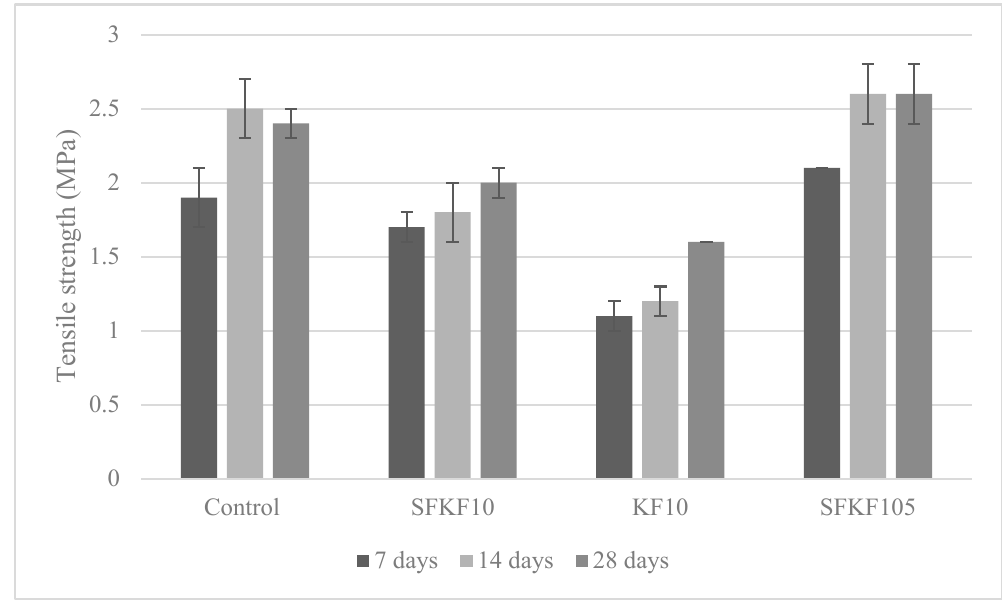
Figure 9. Variation of tensile strength .